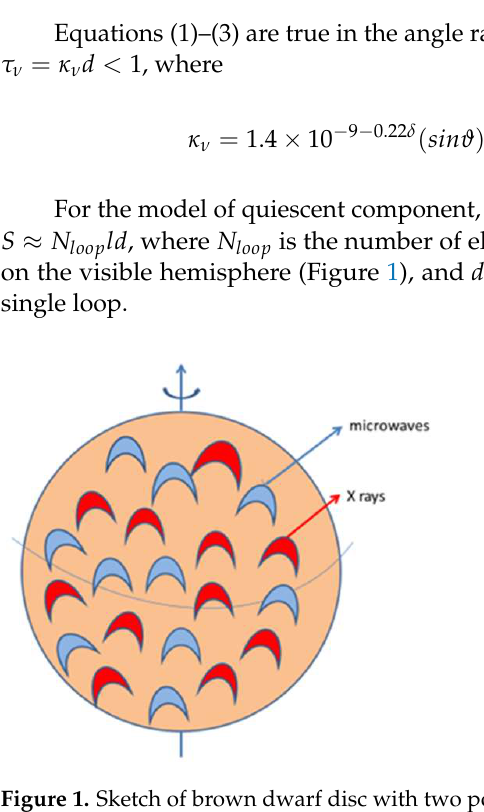
Figure 1. Sketch of brown dwarf disc with two populations of magnetic loops, the sources of “hard” X-ray emission (red), and both microwave and “soft” X-ray radiation (blue). Using the relation α = 1.22 − 0.90 δ from the spectral index of the optically thin radio emission α = − 0.4 ± 0.1, one can determine the spectral index of energetic electrons δ ≈ 1.8 ± 0.1, indicating a rather hard spectrum of emitting particles. Equation (3) for